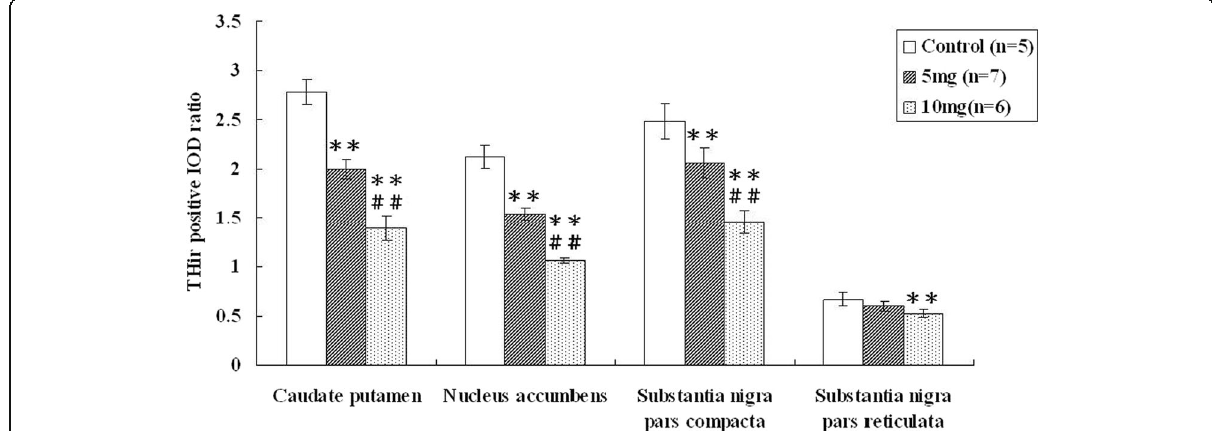
Fig. 6 The integrated optical density (IOD) ratio of tyrosine hydroxylase (TH) immunoreactivity in the caudate-putamen (CP), nucleus accumbens (NA), substantia nigra pars compacta (SNPC), and pars reticulata (SNPR) of the control and METH-induced groups. * p < 0.05 and ** p < 0.01 compared to the control group; # p < 0.05 and ## p < 0.01 compared to the 5 mg/kg group